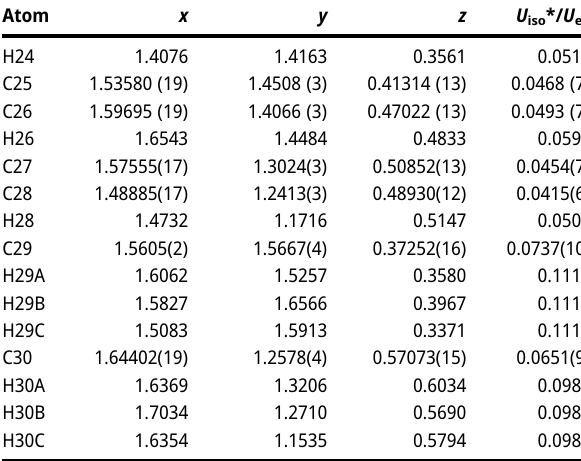
Table  : Fractional atomic coordinates and isotropic or equivalent isotropic displacement parameters (Å 